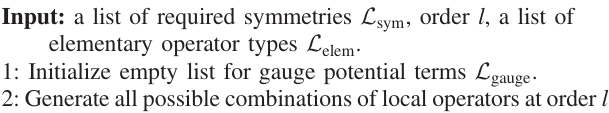
Algorithm 2. Generation of variational gauge